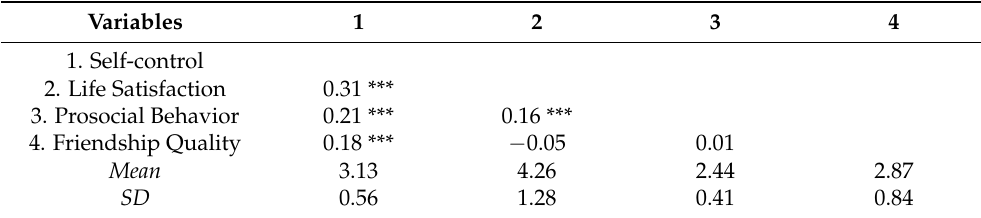
Table 1. Correlations and descriptive statistics for all of variables.